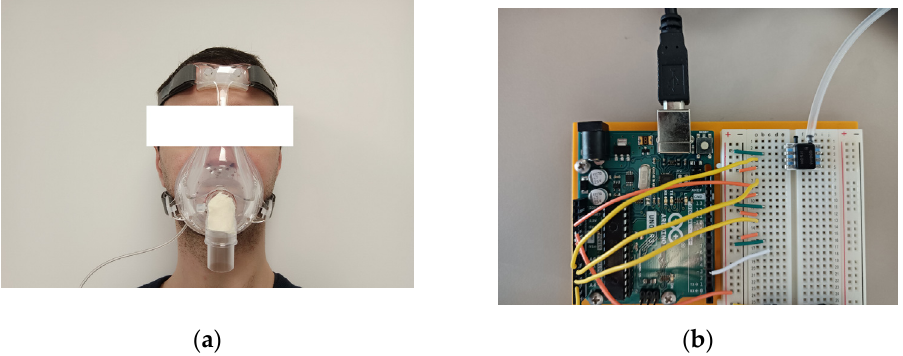
Figure 1. ( a ) A target wearing the mask with the pressure sensor tube coming from below; ( b ) pressure sensor on the right of the board with an Arduino Uno R3 board on the left. Equipment: For the prototyping, we used a Honeywell differential pressure sensor HSCDRRN005NDAA5 of ±5 inH2O ≈ ±12mbar (for more accuracy, it is possible to reduce to ≈ ±5mbar), a facial mask SEFAM Breeze and a silicone tube.